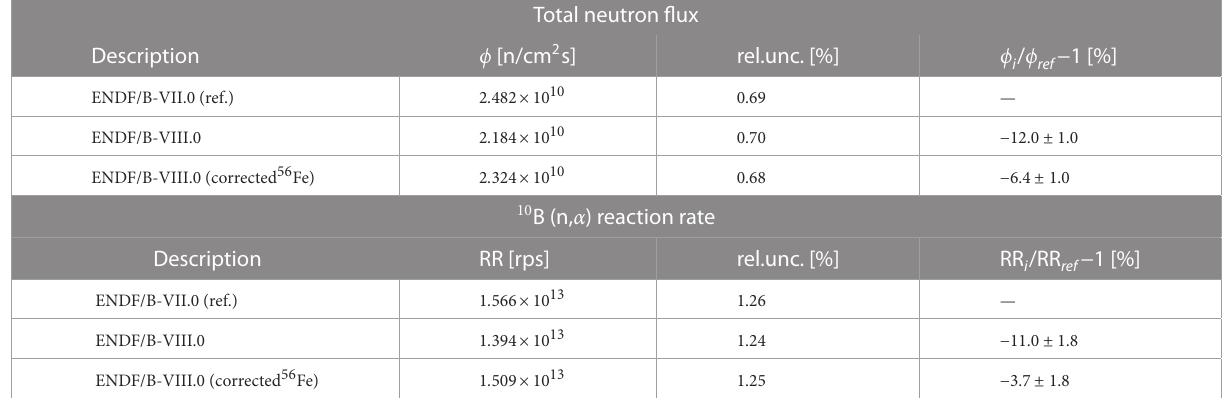
TABLE2 Calculatedabsoluteneutronfluxatex-corepowerrangedetectorlocation,normalizedtothefullreactorpowerof2 GW,fordifferentnucleardata